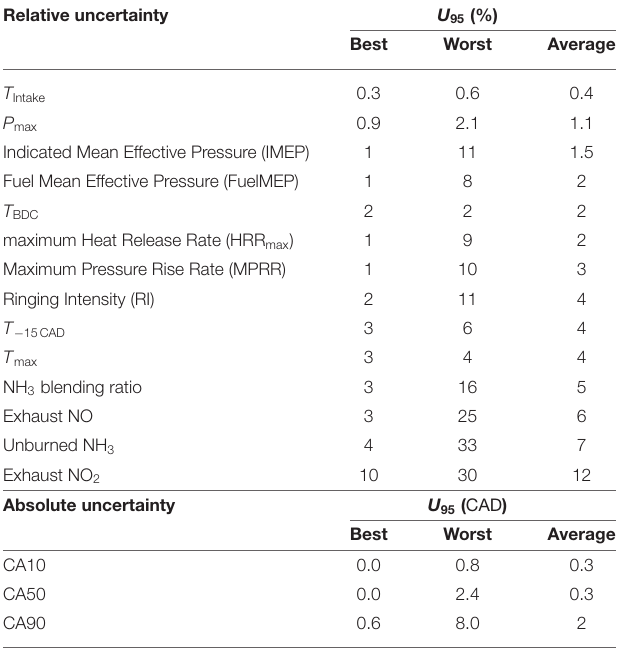
TABLE 2 | Relative uncertainties at a 95% confidence level for every parameter of interest. Relative uncertainty U 95 (%) Best Worst Average